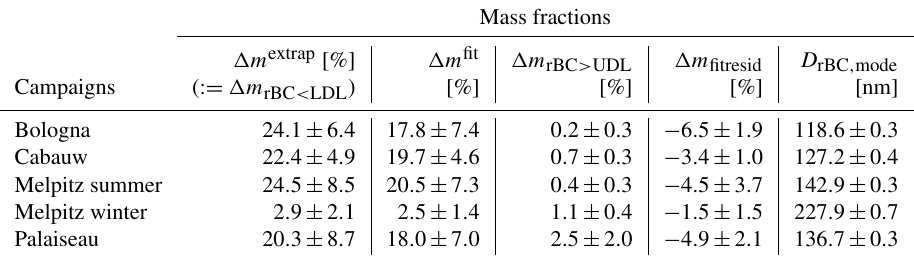
Table 4. Estimates of potentially missed rBC mass for the two methods ( (cid:49)m extrap and (cid:49)m fit ), summands contributing to it ( (cid:49)m rBC > UDL and (cid:49)m fitresid ) and modal diameter of the averaged rBC mass size distribution, all separately listed for each campaign. The size range of 80–300nm rBC mass equivalent diameter was chosen for fitting the measurement. The sensitivity of the results to this choice was negligible, as discussed in the